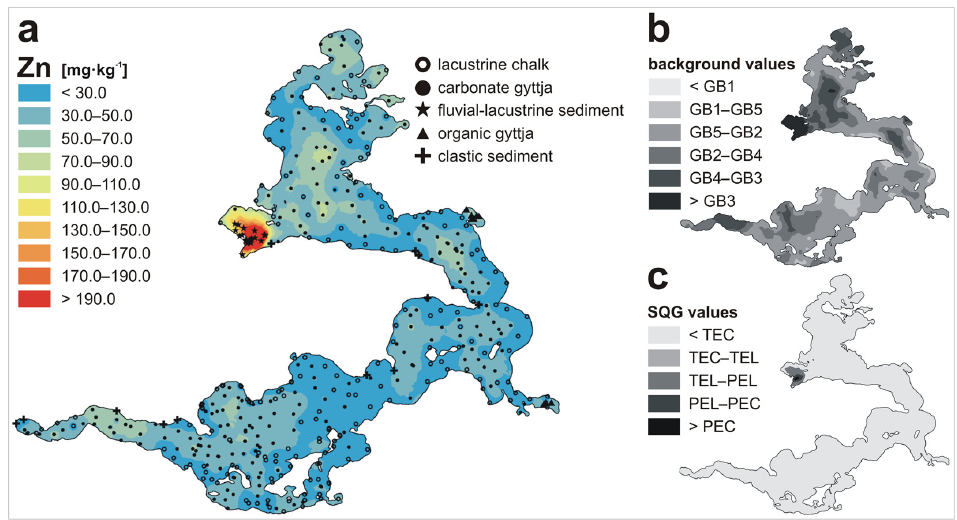
Figure 8. Zinc in recent bottom sediments of the Wigry Lake: ( a ) spatial distribution of Zn; ( b ) Zn mapped according to different geochemical background values implemented in the study (Table 3); ( c ) Zn mapped according to sediment quality guideline values (TEL—threshold effect level, TEC— threshold effect concentration, PEL—probable effect level, PEC—probable effect concentration [59,60]; Table 3).